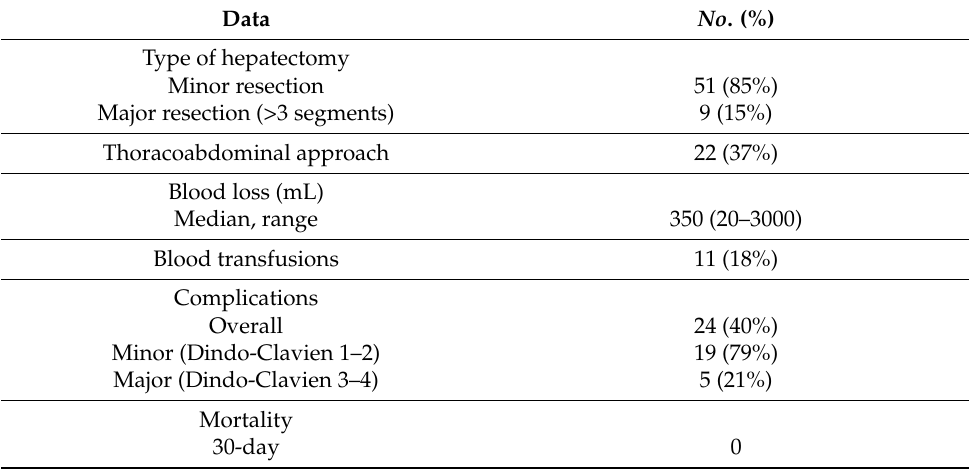
Table 2. Surgical and short-term outcome